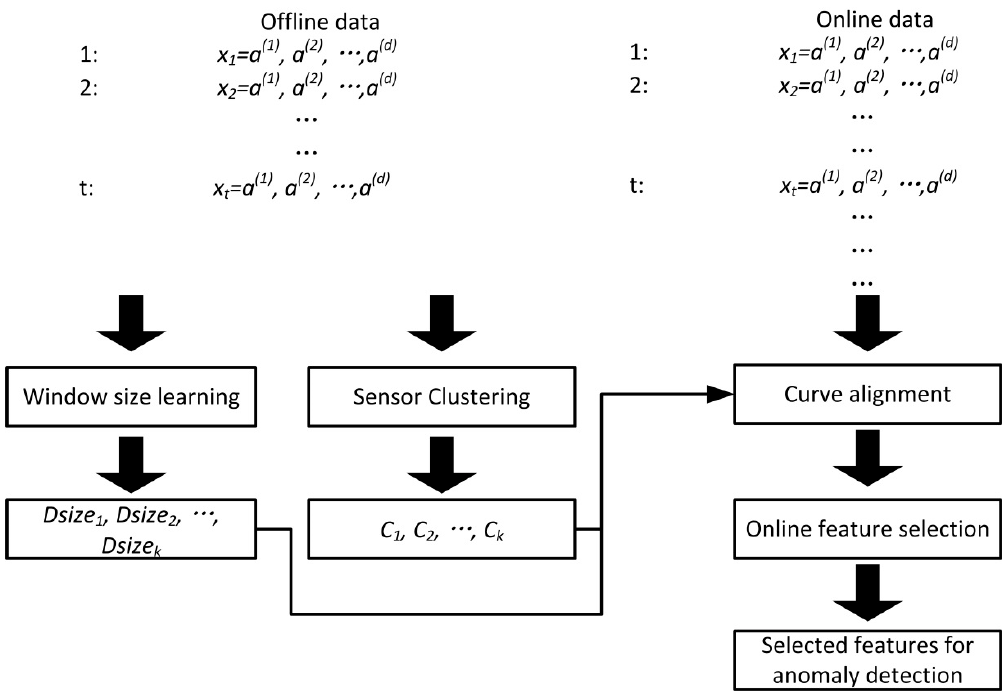
Figure 3. Revised workflow of our method.